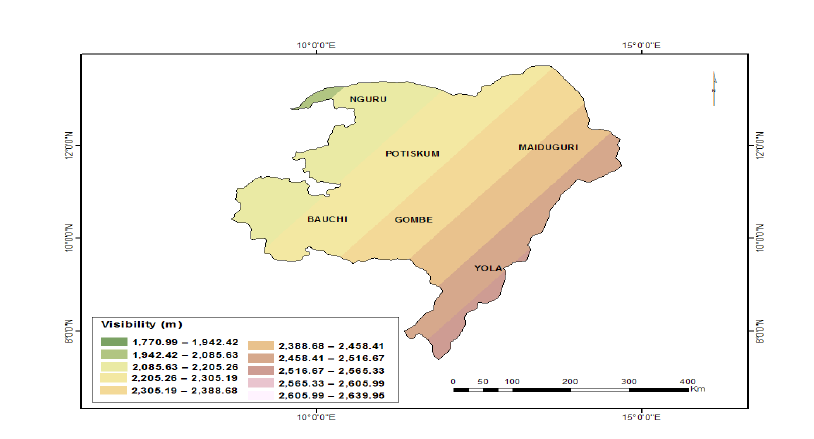
Figure 12: Spatial Air Visibility Distribution in Northeastern Nigeria (1999/2000 – 2003/2004).